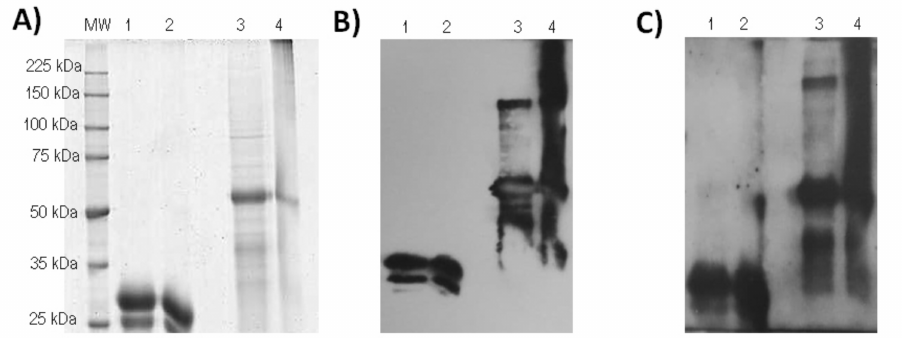
Figure 3. Comparison of the RBD-H6-HEK and RBD-CD proteins, both obtained in the same expression system, the HEK-293 cell line. ( A ) Coomassie Blue stained 10% SDS-PAGE gel under non-reducing conditions (NRC) and reducing conditions (RC). ( B ) Western blotting using an anti-His monoclonal antibody (dilution 1:2000) under NRC and RC. ( C ) Western blotting using sera from SARS- CoV2 naturally infected and recovered patients (dilution 1:250) and HRP-conjugated anti-human IgG (dilution 1:10,000), under NRC and RC. MW: molecular weight marker, lane 1: RBD-H6-HEK RC, lane 2: RBD-H6-HEK NRC, lane 3: RBD-CD RC, lane 4: RBD-CD